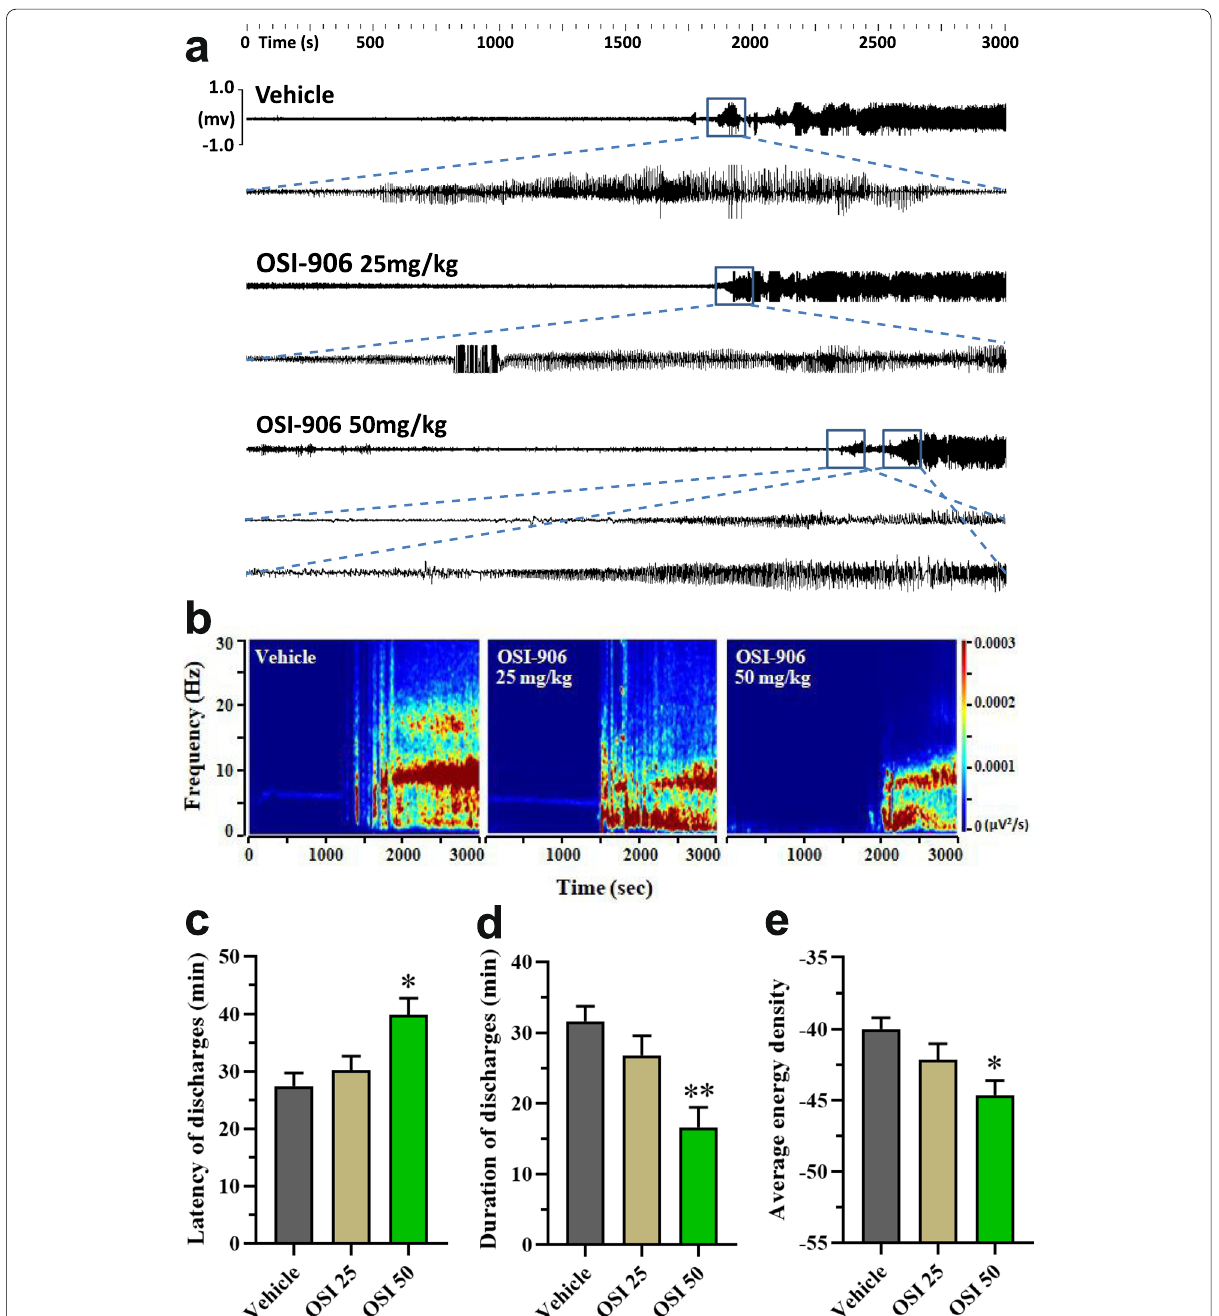
Fig. 3 Effects of OSI-906 on epileptic discharge in acute epileptic seizures. ( a ) Effects of OSI-906 on hippocampal electrical activity (the X-axis is 60 min and the Y-axis is 1.0 millivolts). ( b ) Corresponding power spectrograms of each group. ( c‑e ) 50 mg/kg OSI-906 shortened the latency of ± epileptic discharge, and reduced the duration of epileptic discharge and the mean energy density value of brain electrical activity. Data are shown as mean SEM. * P < 0.05 and ** P < 0.01 compared to the control group; n 5 each ± =